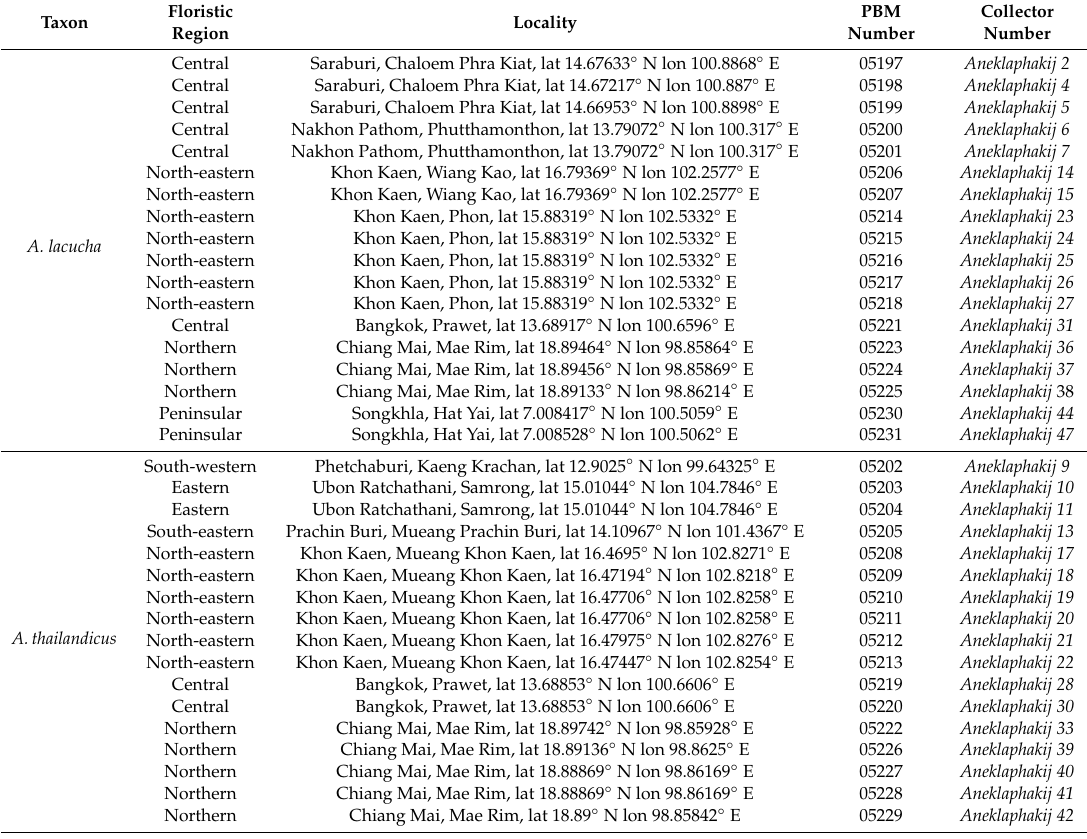
Table 2. List of the studied